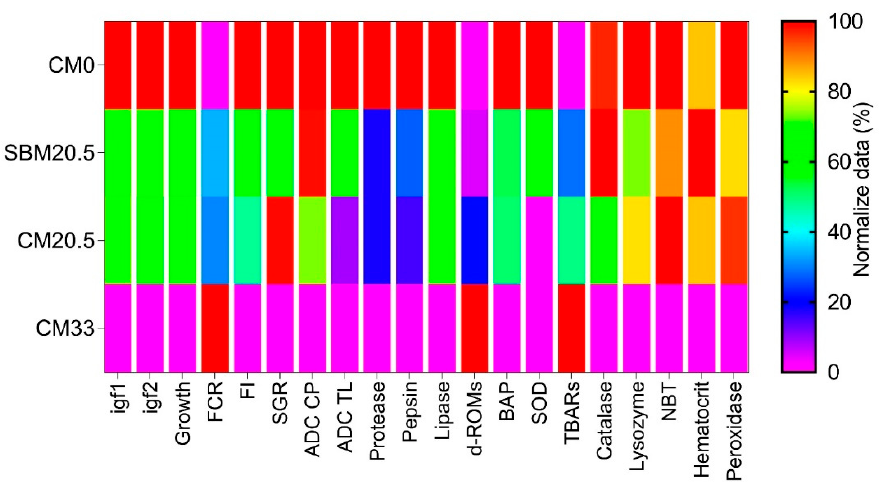
Figure 5. Heatmap diagram of red seabream fed four different diets by replacing fish meal with camelina meal at 0% for reference diet (CM0), 20.5 g/kg with soybean mean (SBM20.5), 20.5 g/kg with camelina meal (CM20.5), and 33 g/kg camelina meal (CM33). The horizontal axis showed the parameters being assessed, and the vertical axis showed the dietary groupings. The legend showed the normalized (0–100% scale) mean values of each parameter in the investigation. The red bar and purple bar represent the highest and lowest mean responses, respectively. In the Figure 5 abbreviations in the horizontal axis are define as follows: igf1 and igf2 represent growth factor gene 1 and growth factor gene 2 respectively, Growth: Final weight growth weight, FCR: Feed Conversion ratio FI: Feed intake, SGR: specific growth rate, ADC CP: Apparent nutrient digestibility of protein, ADC TL: Apparent nutrient digestibility of Total Lipid, d -ROMs: Reactive Oxygen Metabolites, BAP: Biological Antioxidant Potential, SOD, Superoxide Dismutase, TBARs, Thiobarbutic